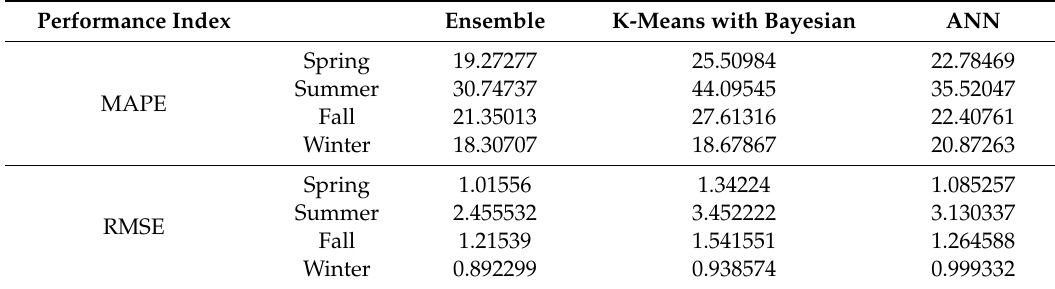
Table 5. Prediction accuracy of forecasting testbed